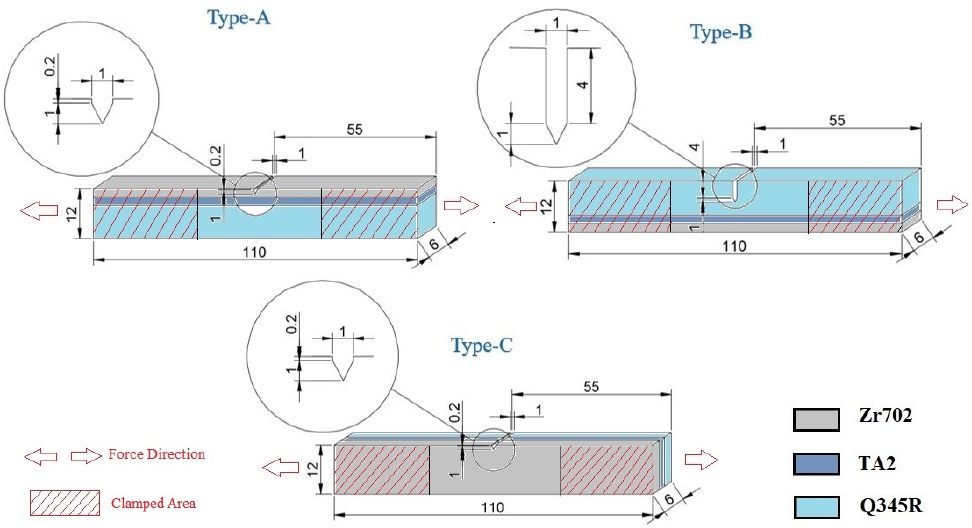
Figure 1. Diagram of Type-A, Type-B and Type-C specimens.